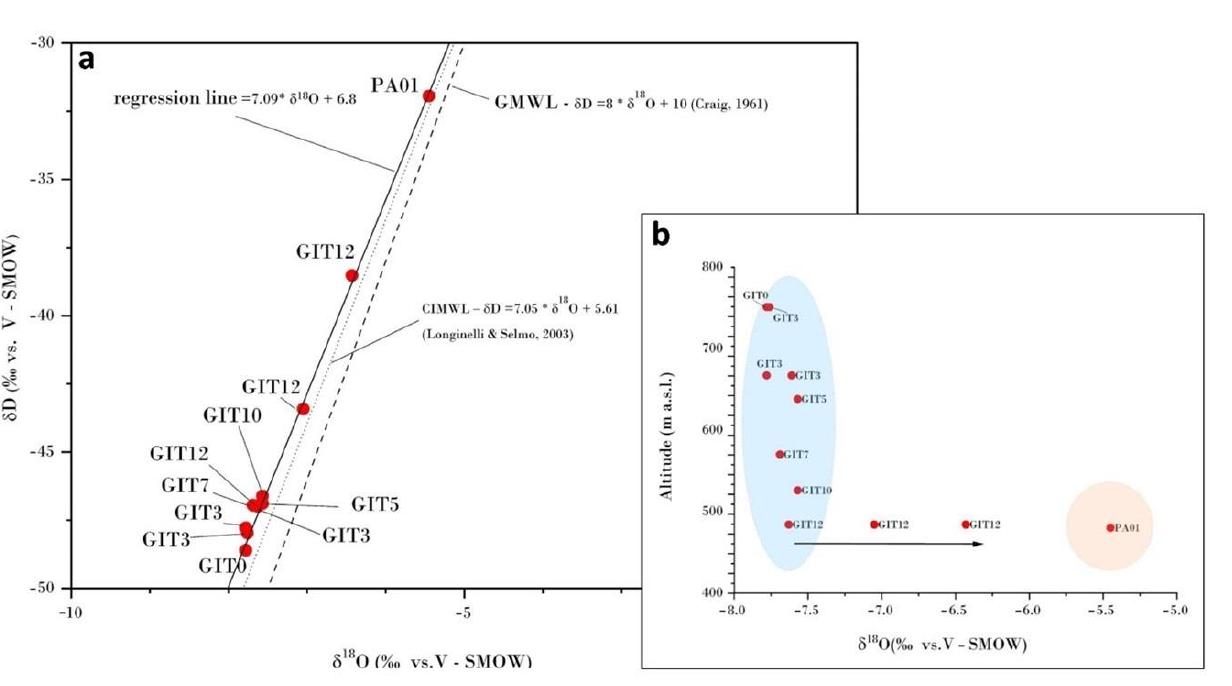
Figure 4. ( a ) The binary diagram of δ D vs. δ 18 O in FdC waters (red circles). The Central Italy (CIMWL, [25]), and the Global Meteoric Water (GMWL, [24]) lines are reported for comparison with the regression line depicted by the studied waters. Graph ( b ) correlates the altitude (in m) vs. the δ 18 O values. The blue field contains most of the FdC waters, whose isotopic oxygen values decrease with altitude. The black arrow points to the isotopic composition of the FdC waters collected before entering the Pagliola river and the Pagliola creek itself.